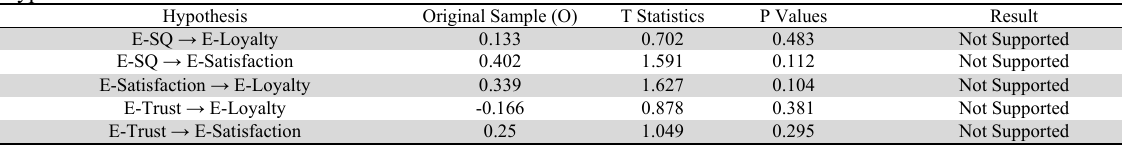
Hypothesis Result of the Structural Model